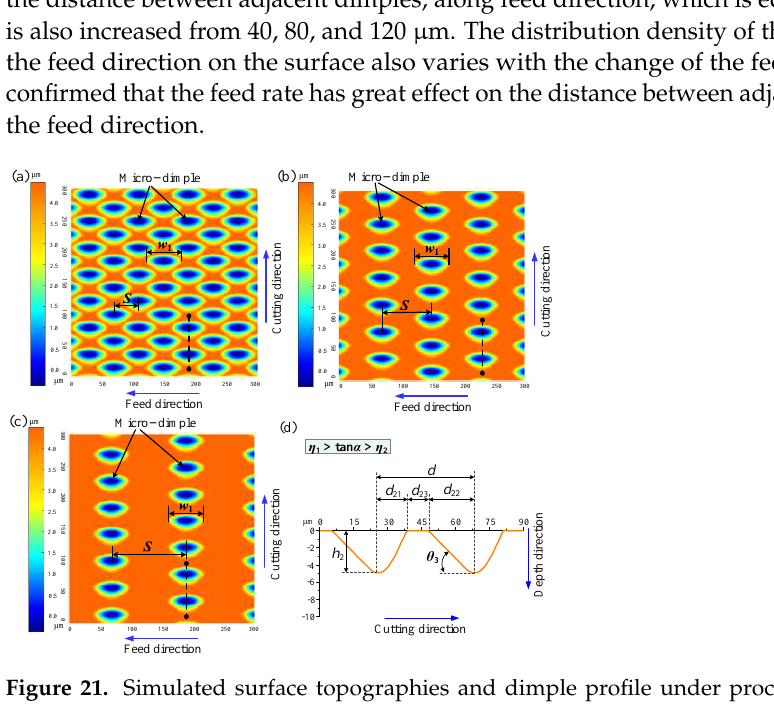
19,670 Hz, A = 3. 9 μ m, R = 20 mm, DOC = 1 μ m, n = 400 r/min, α = 15°, R c = 10 0 μ m. ( a ) f = 4 0 μ m/rev; f us = 19,670 Hz, A = 3.9 µ m, R = 20 mm, DOC = 1 µ m, n = 400 r/min, α = 15 ◦ , R c = 100 µ m.